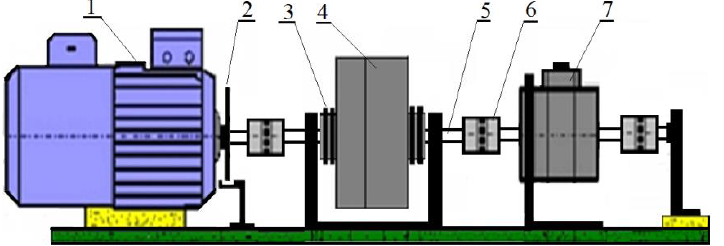
Figure 5. Test bench scheme: 1 — electric motor, 2 — speed sensor, 3 — slip rings used to supply high voltage, 4 — the tested brake with ER fluid, 5 — shaft, 6 — connecting clutch, 7 — torque gauge.